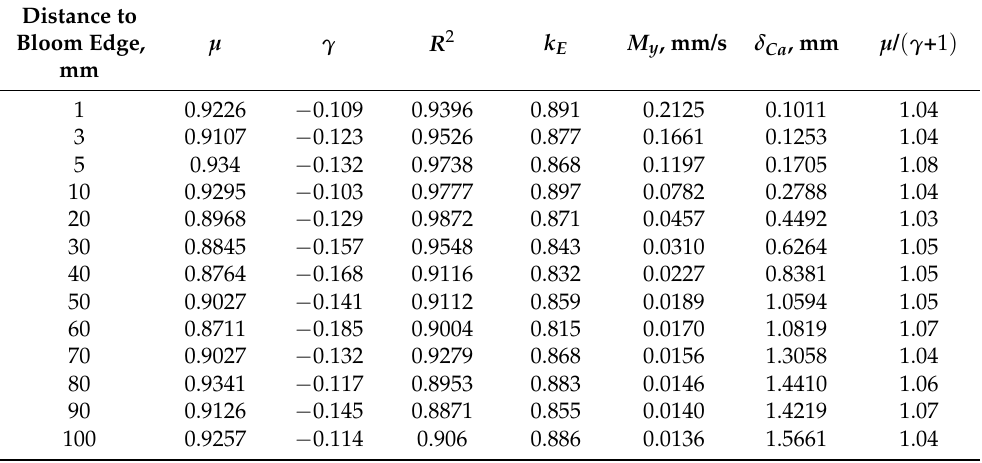
Table 3. Fitted and calculated results in the outer curve side under 20 ◦ C ( µ , γ are fitted coefficients in Equation (3), and R 2 is the corresponding determination coefficient. k E is the effective solute redistribution coefficient. M y is growth velocity magnitude in the solidification unit along the measuring line at each position. δ Ca is the average thickness of the concentration boundary layer). Distance